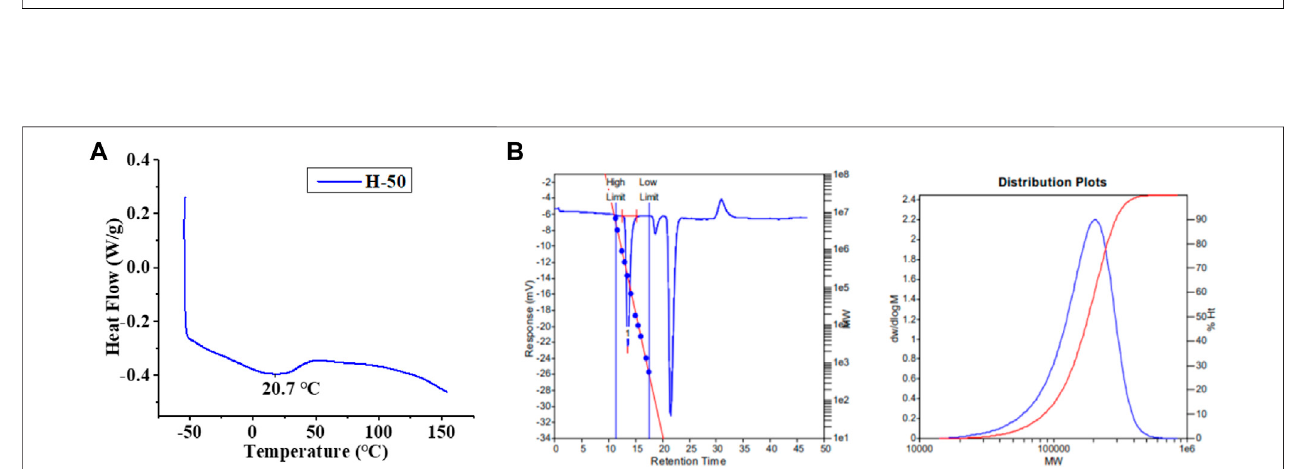
FIGURE 3 | Comparisons on yield (A) , molecular weight (B) , and branching density (C) of polyethylene yielded with catalysts Ni1-Ni5 at 30 – 70 ° C.